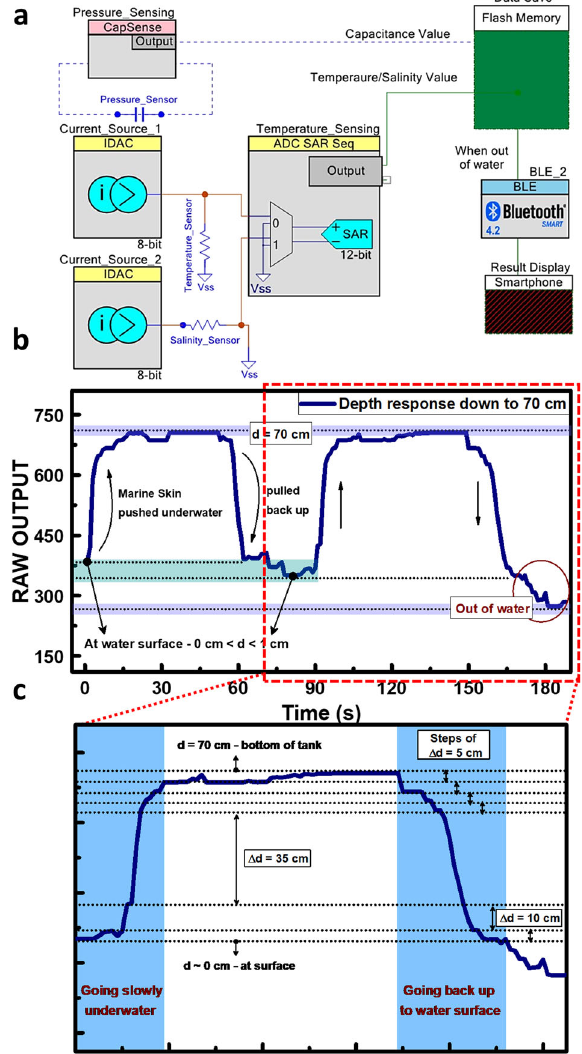
Fig. 4 Autonomous and conformal wireless marine system. a System schematics and block diagrams of the Marine skin sensory system integrating a BLE chip and a battery. b Waterproofed system integrity with performance testing in sea water under 70 cm deep tank. c Zoomed-in depth response collected from the sensory system as it is pushed down to 70